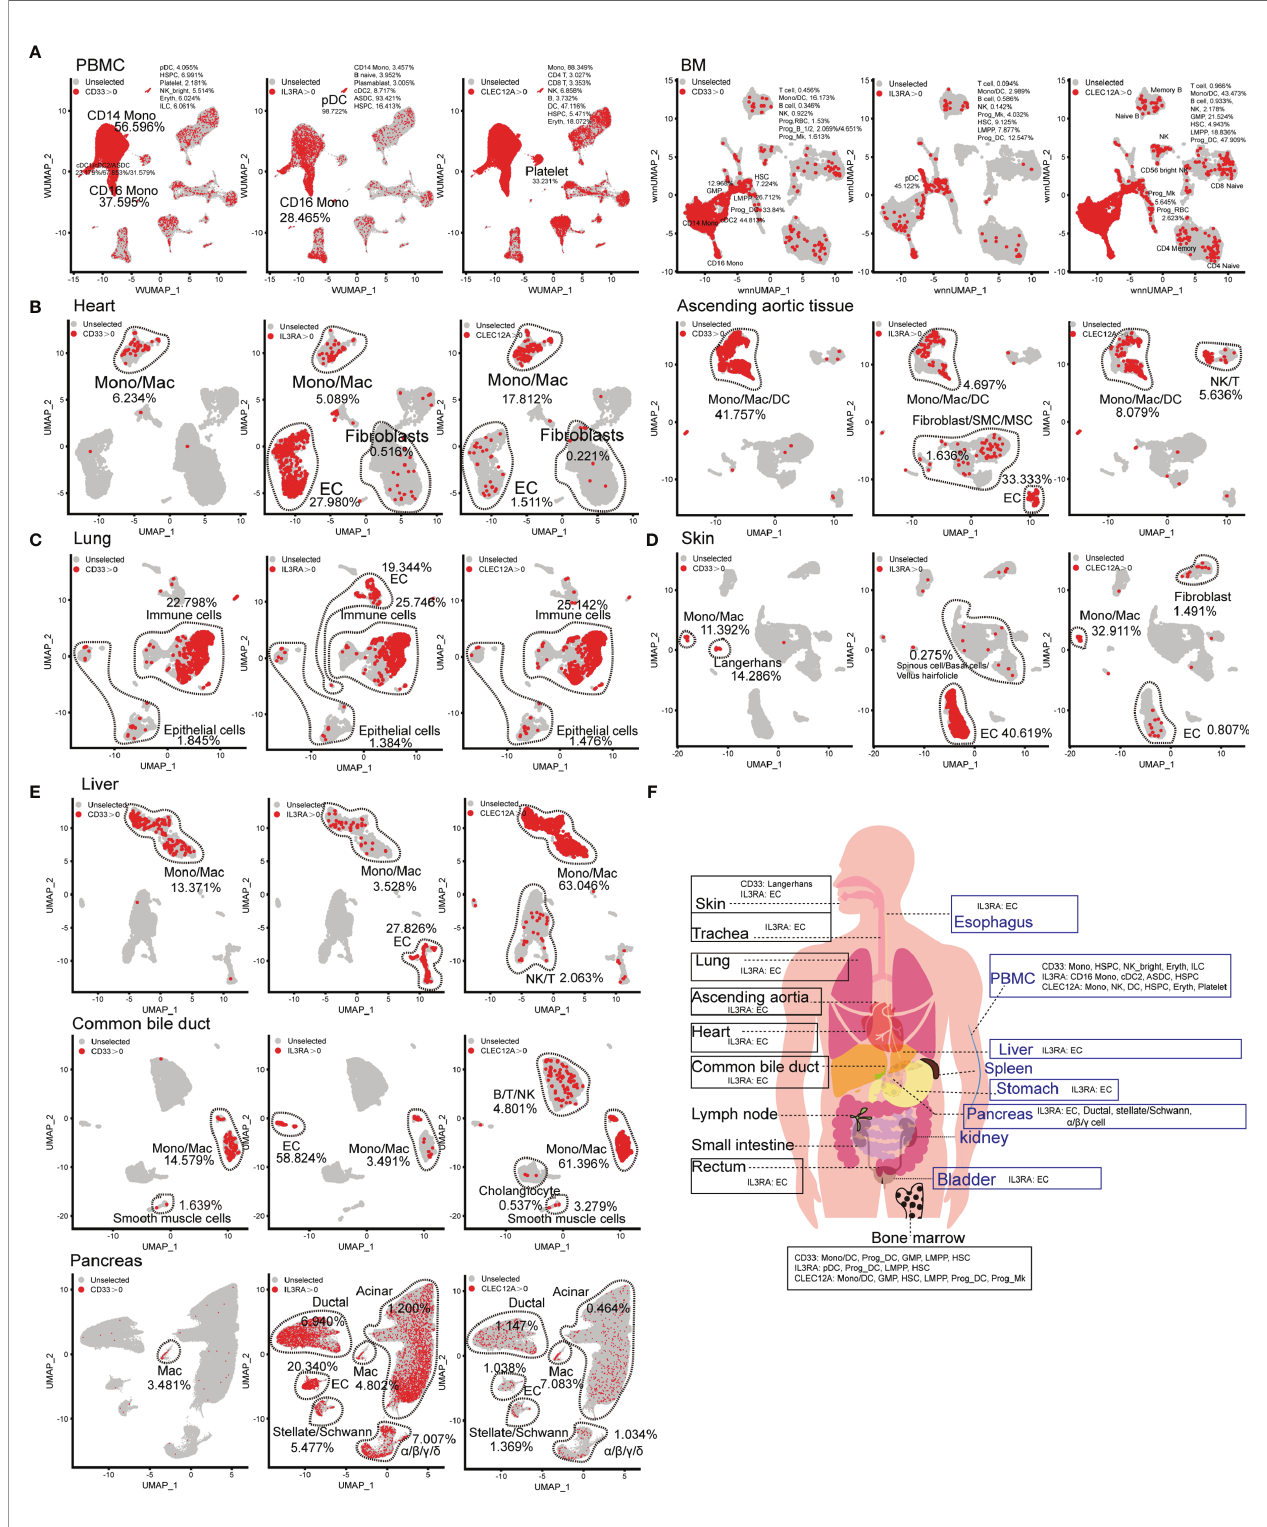
FIGURE 3 | Expression pattern of AML antigens (CD33, IL3RA, and CLEC12A) in human normal tissue and organs. CD33, IL3RA, and CLEC12A-expressing proportions (expression value >0) of PBMC/BM-derived cells (A) , heart-derived cells, ascending aortic tissue-derived cells (B) , lung-derived cells (C) , skin-derived cells (D) , liver-derived cells, common bile duct-derived cells, pancreas-derived cells (E) , are illustrated in UMAP plots. (F) Schematic diagram of high AML antigen- expressing cell types in different tissues and